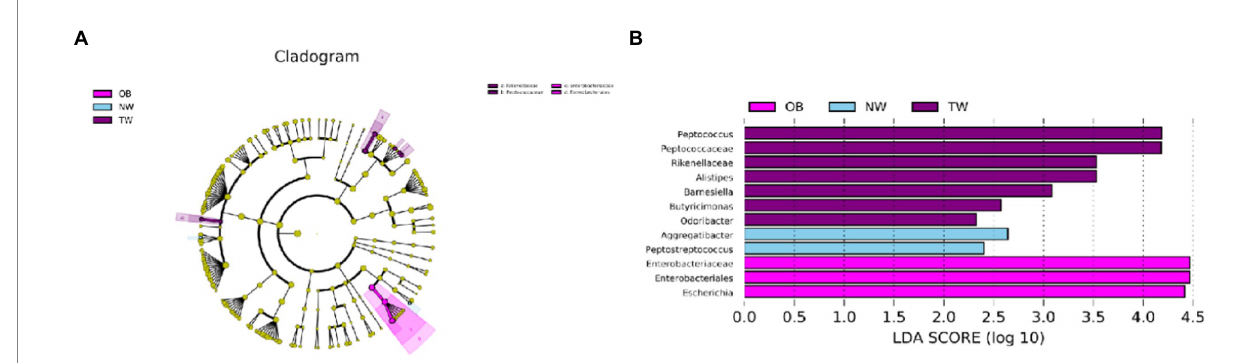
FIGURE 5 Taxonomic differences in the microbial 16S rRNA gene by a LEfSe analysis. (A) Differences in gut bacterial taxa, from the phylum level to the species level, are represented by a cladogram (red indicates taxa enriched in the non-overweight group and green indicates taxa enriched in the overweight